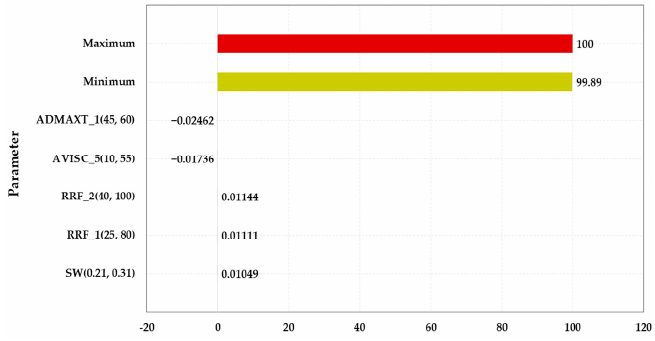
Figure 9. Parameter sensitivity analysis of the water cut of the HPL.